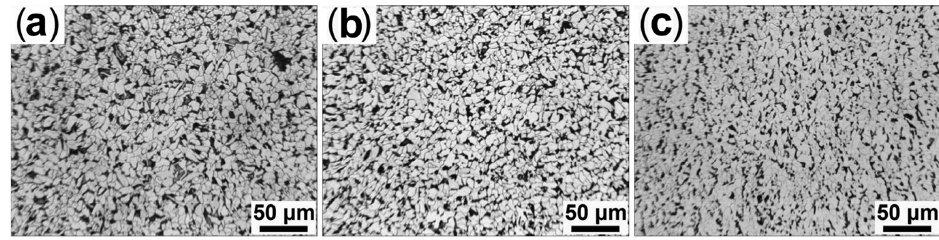
Figure 2: The forged microstructures in three steels, (a) steel No.1; (b) steel No.2; (c) steel No.3.